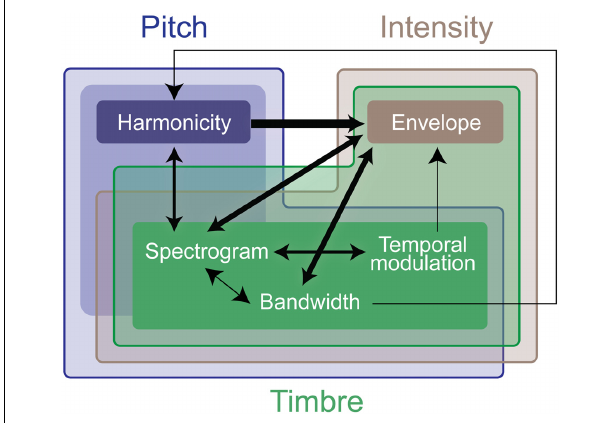
FIGURE 7 | Summary of interaction weights that emerge from training the computational model. The model is trained using the same stimuli used in the experimental testing. Thicker lines denote higher weights. An arrow between features indicates that the origin feature of the line boosts the effect of the destination of the line. The different colors indicate the computational features that encode effects of the experimental features, the deeper the color, the stronger the relationship. As in Figure 4 , the weight and directionality of interactions in this figure are inferred from the coefficients of the fitted model, and are limited by the levels of sound features tested in the human